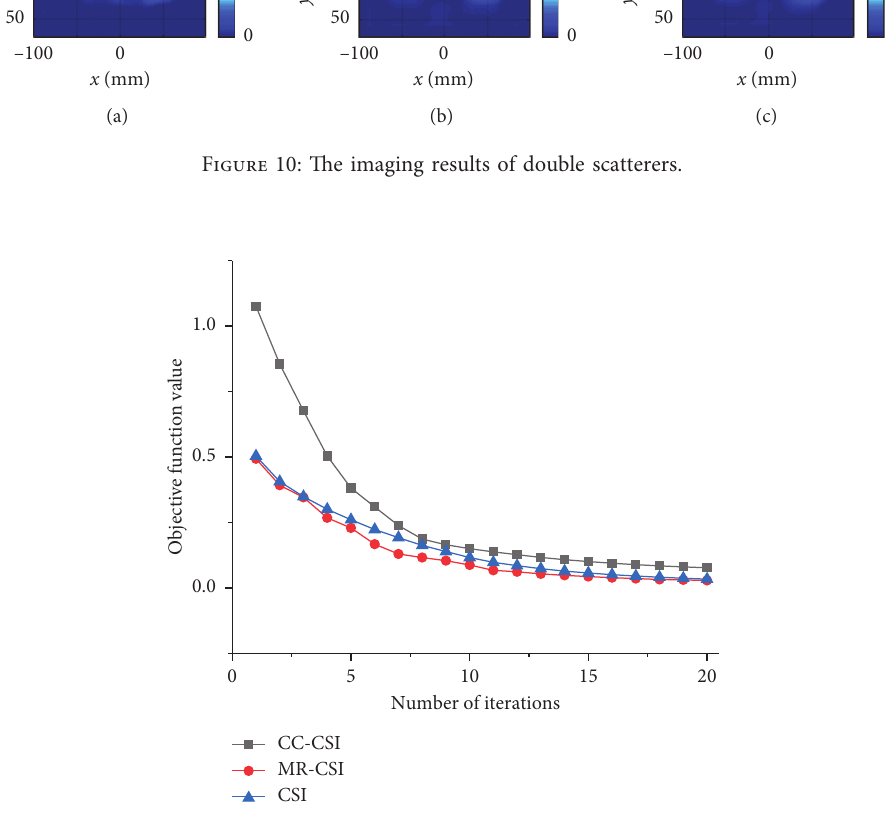
Figure 11: The objective function values of the double scatterers.